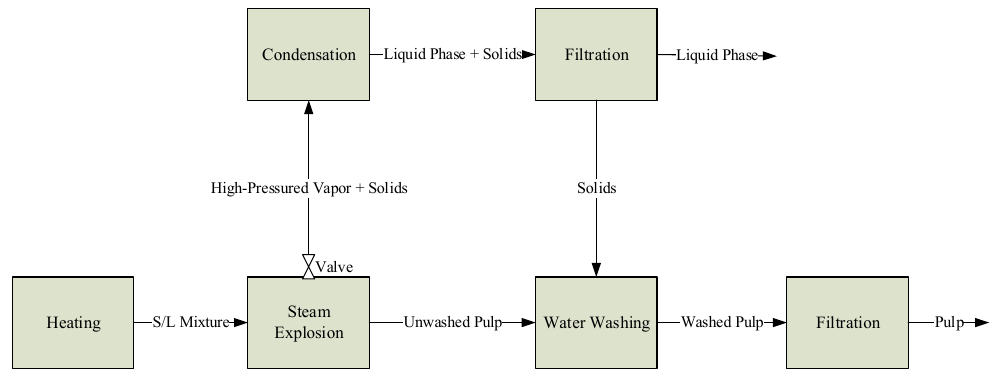
Figure 1. The experiment diagram of the steam explosion pretreatment.